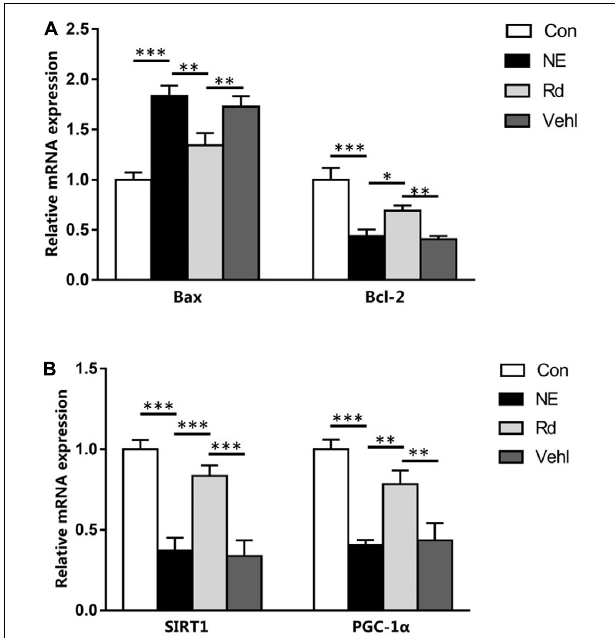
FIGURE 4 | Summarized data showing the levels of Bax, Bcl-2 (A) , SIRT1, and PGC-1 α (B) in the auditory cortices of guinea pigs in the four groups. N = 6 in each group. The values are presented as the means ± SE. * P < 0.05, ** p < 0.01, *** p <